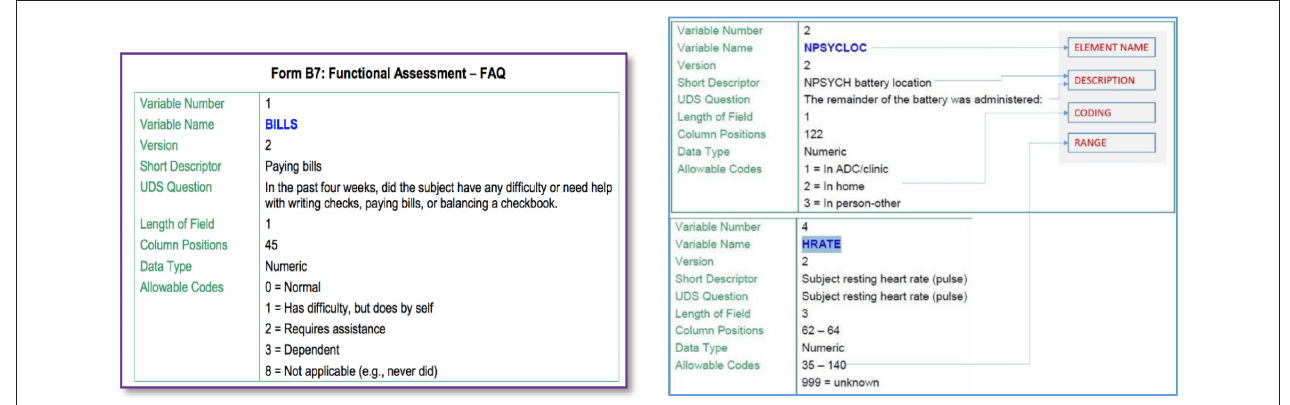
FIGURE 2 | Element information in data